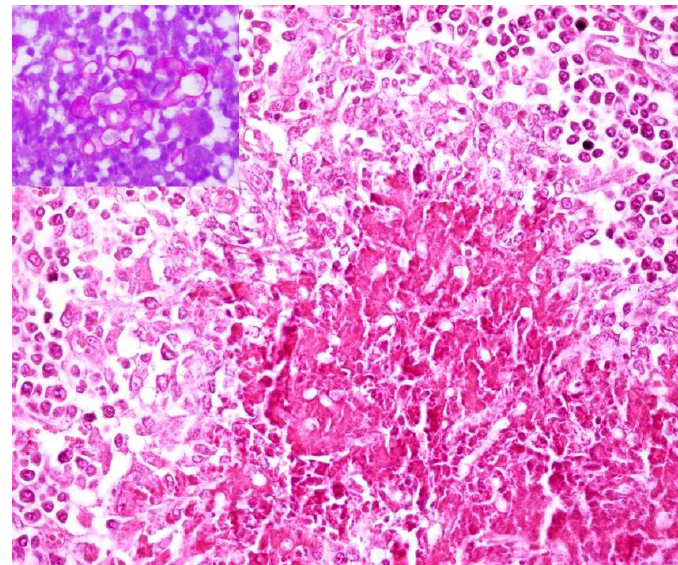
figura 6. Fotomicrografia da lesão rinofaringea da conidiobolomicose em ovino (2PS). Verifica-se reação de Splendore-Hoeppli com imagens negativas de hifas envoltas por infiltrado inflamatório granulomatoso. HE, obj. 40x. No detalhe, hifas largas, com paredes finas vermelhas com dilatação balonosa em uma de suas extremidades. Ovino 1SS. PAS, Obj. 40x.